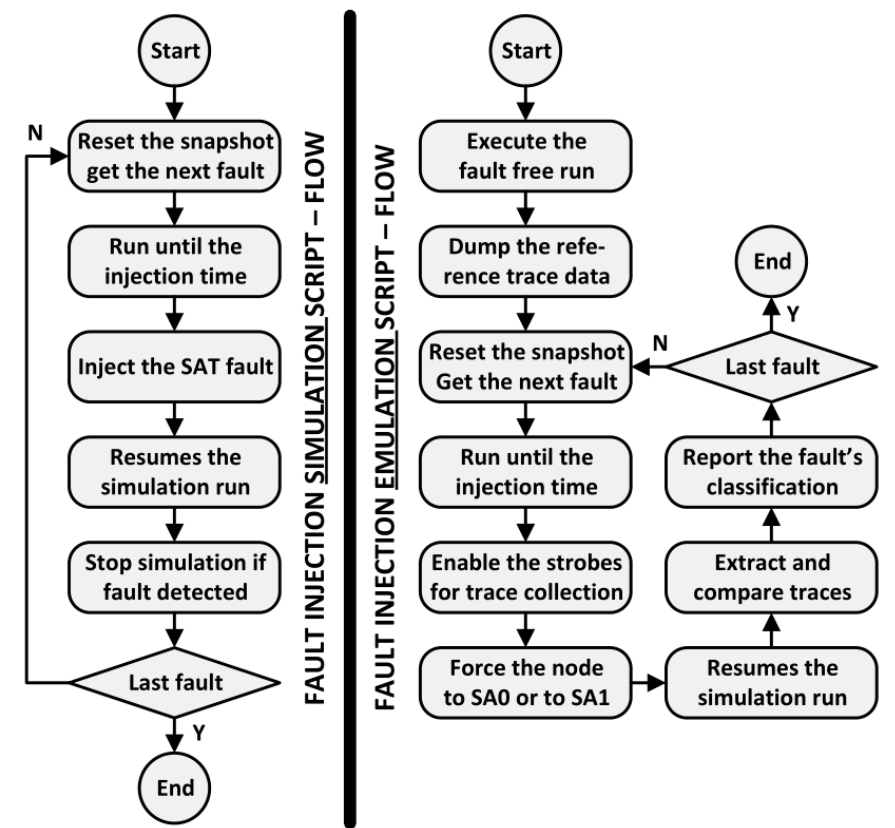
Figure 6. The execution flow of the developed scripts for the simulation and the emulation